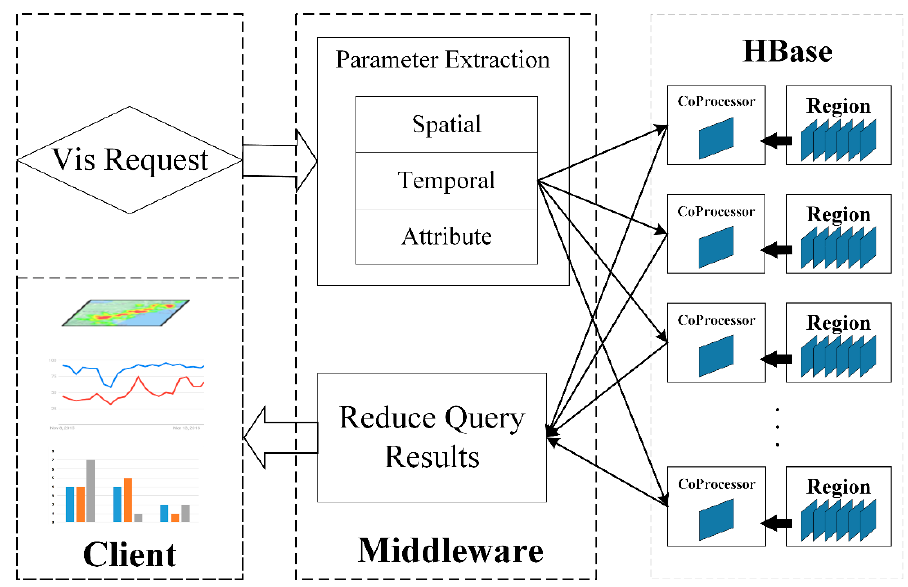
Figure 9. The multidimensional query process in the proposed MAP-Vis.